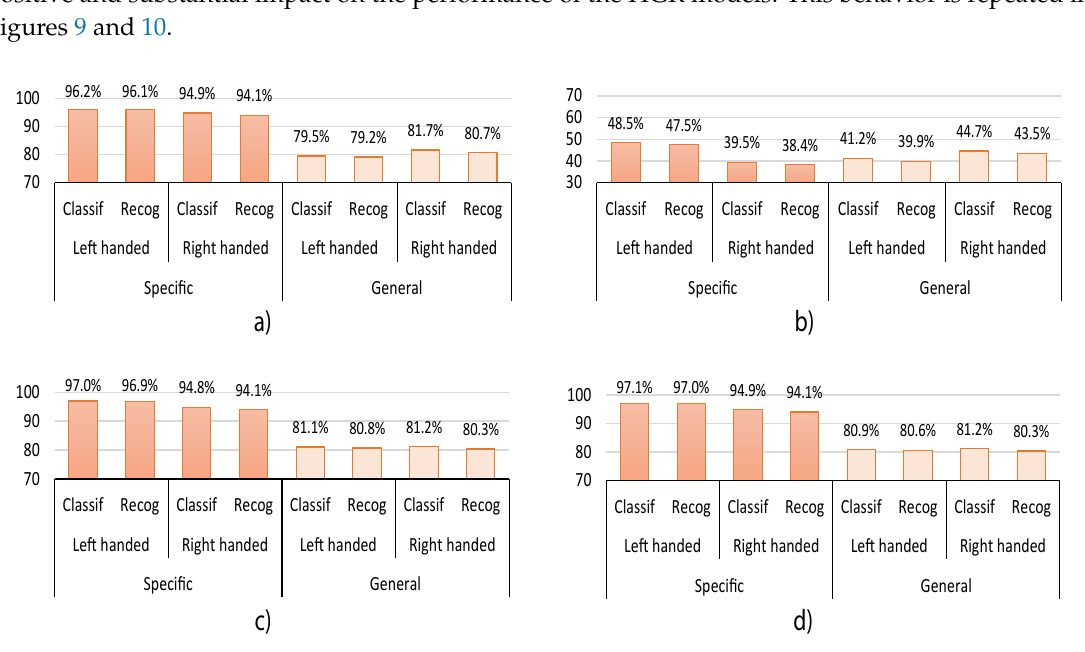
Figure 10. HGR classification and recognition accuracy results considering handedness preference for user-specific and user-general models obtained for ( a ) experiment 1 , ( b ) experiment 2 , ( c ) experiment 3 , and ( d ) experiment 4